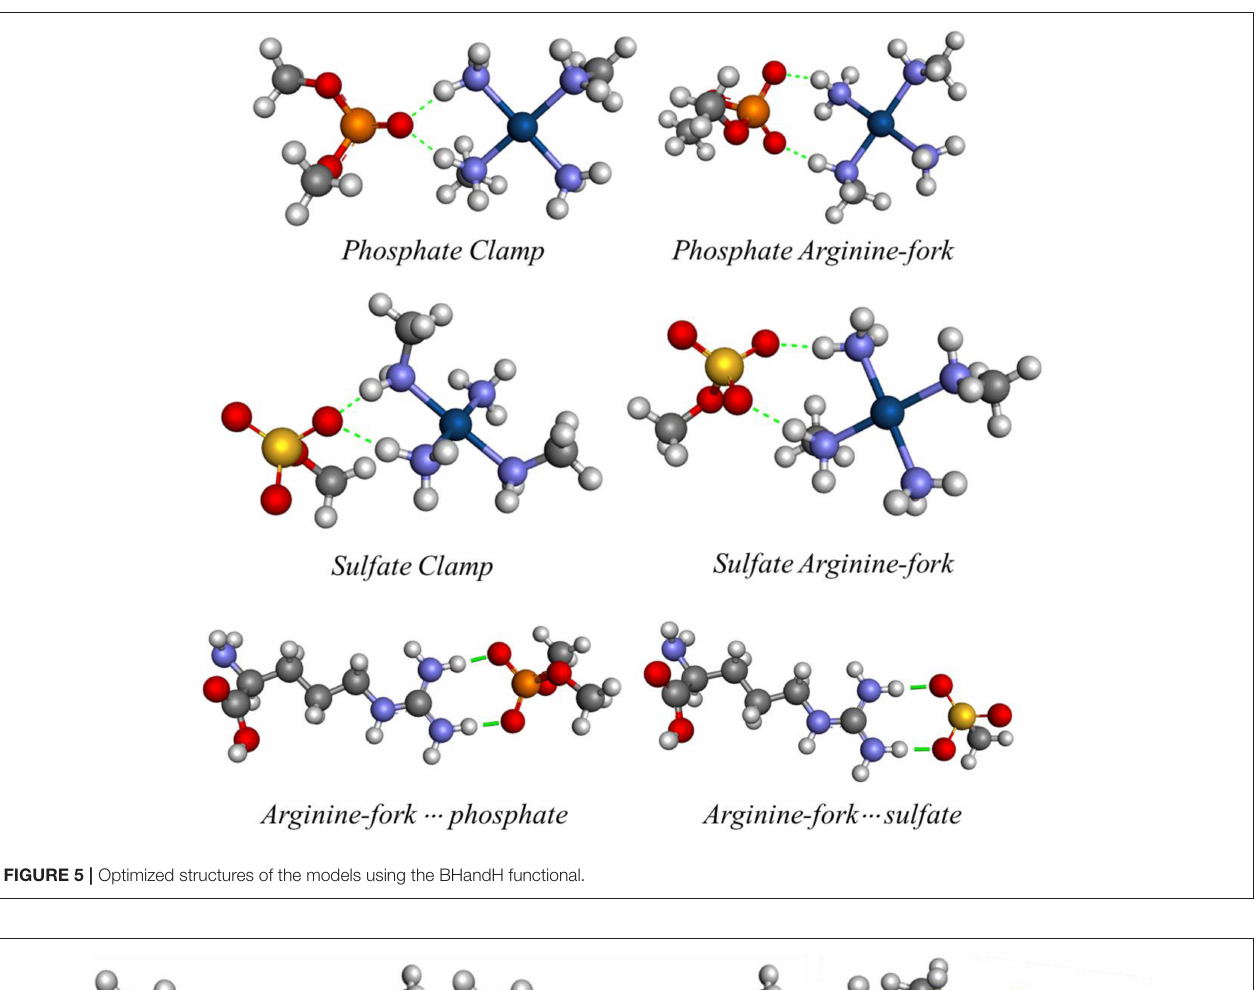
FIGURE 5 | Optimized structures of the models using the BHandH functional.